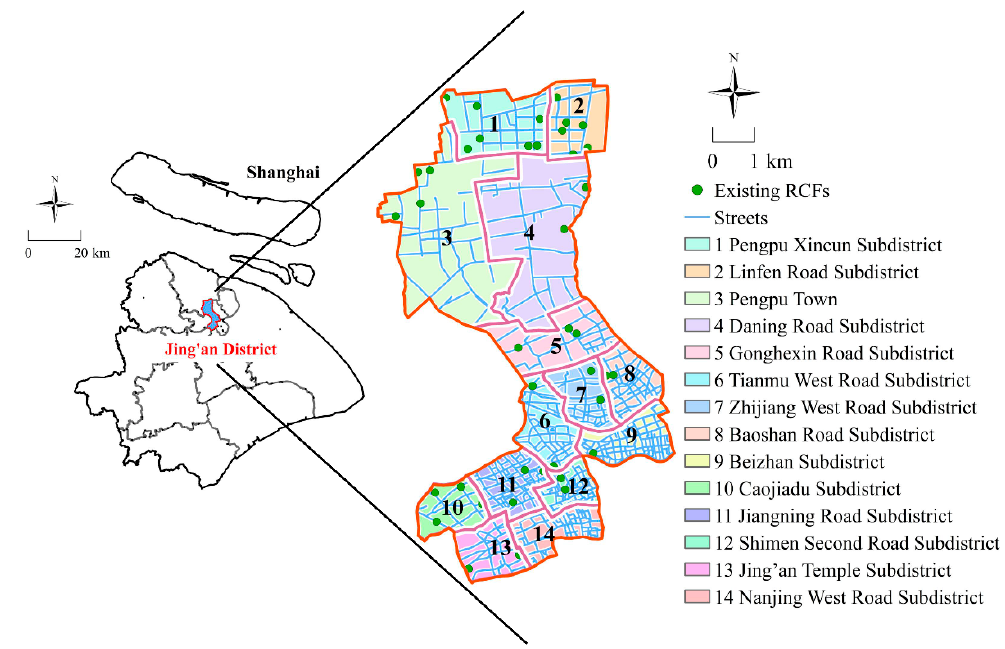
Figure 2. Location of Jing’an District and the spatial distribution of existing residential care facilities (RCFs).